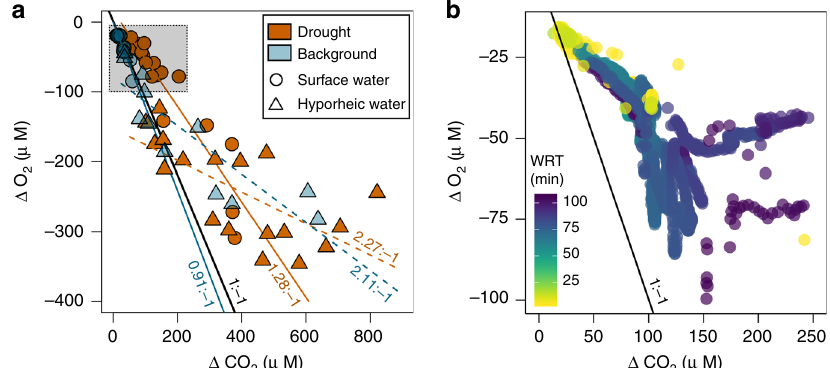
Fig. 4 Experimental drought caused stochiometric imbalances between O 2 and CO 2 . Relationships between the molar departure of stream CO 2 and O 2 from atmospheric equilibrium ( Δ CO 2 : Δ O 2 ) assessed from a , low-frequency (i.e., grab samples) and b , high-frequency (i.e., sensor data) sampling. Circles and triangles denote surface and hyporheic water observations, respectively (note that panel b is only surface water). Orange and blue colors in panel a denote drought and background (pre- and post drought) hydrological conditions, respectively. Color pattern in panel b indicates changes in stream water residence time (WRT) during the experiment. The black line in panels a and b denotes the theoretical 1: – 1 relationship de fi ned for aerobic respiration. Solid and dashed lines in panel a represent the linear regression model for surface and hyporheic observations, respectively, either during drought (orange) or background (blue) conditions. The upper left square in panel a is a reference showing the space of the x – y plane captured by high-frequency data in panel b . Additional metrics associated with the analysis of Δ CO 2 : Δ O 2 are presented in Supplementary Table (2 weeks) underscores the sensitivity of these headwater ecosystems to extreme low- fl ow conditions during drought.